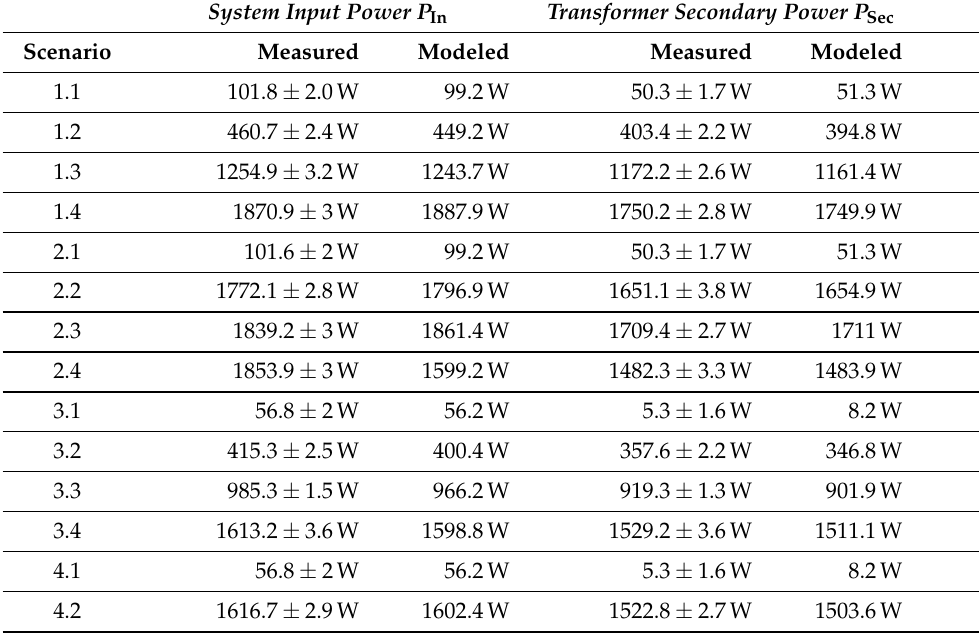
Table A2. Measured and modeled values for system input power and transformer secondary